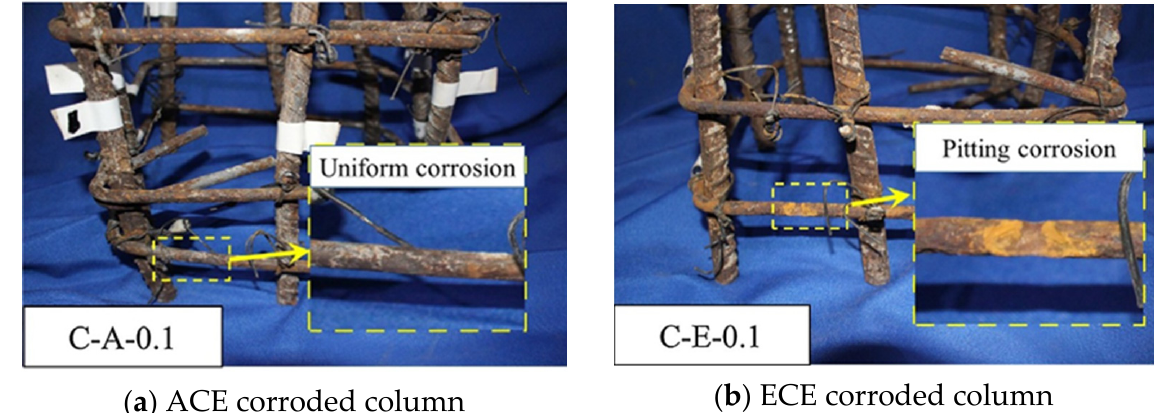
Figure 8. Comparison of corrosion pa tt erns with ACE and ECE techniques . Reproduced with permission from [96], Elsevier, 2020.